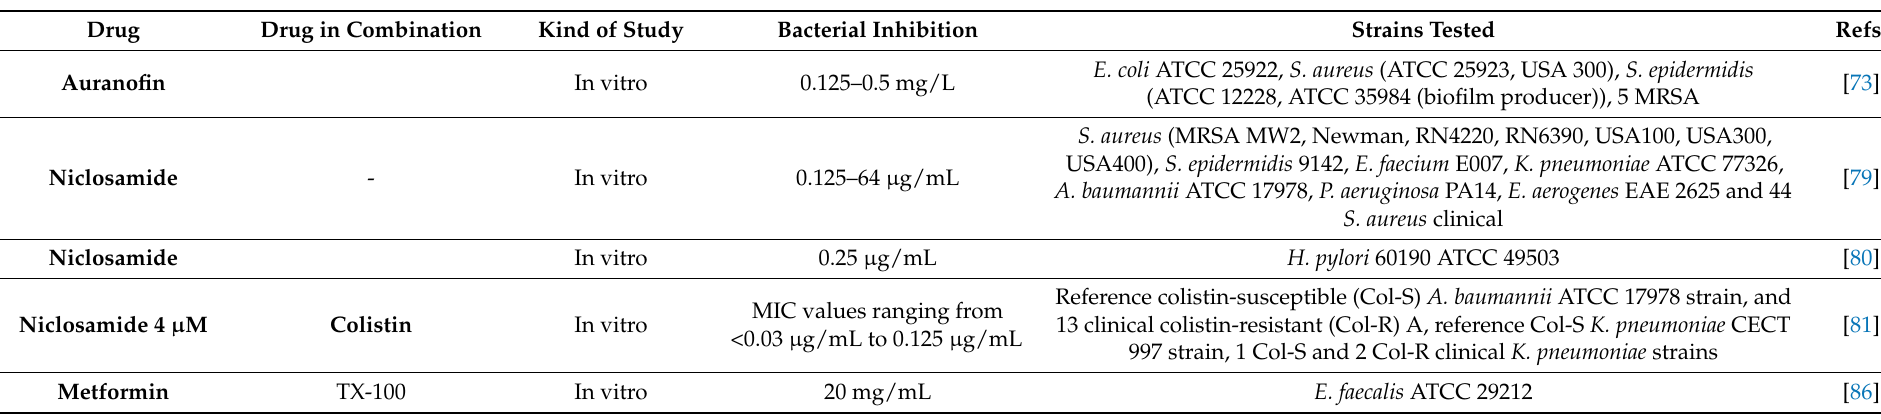
Table 4. Antimicrobial activity of other